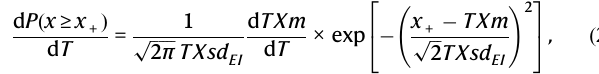
Fig. 5 | Scaling behavior of regional extremes. Multimodel total changes in a , b thehottest days TXx and c , d the coldest nights TNn against changes inglobal- mean surface air temperature (GSAT), regionally averaged over a the Euro- Mediterraneanzone(EMD,land-onlygridpointsin30N-55N,10W-40E)inJune-July- August (JJA), b Central South America (CSA, land-only grid points in 2S-30S, 40W- 73W) in September-October-November (SON), c the Pan-Arctic zone (PAr, 67N- 90N) and d northern mid-to-high latitudes (MHL, 45N-67N) in December-January- February (DJF). Gray dots denote the intermodel spread. Also shown are the cor- responding multimodel changes in the seasonal( Δ TXm and Δ TNm ) and the annual